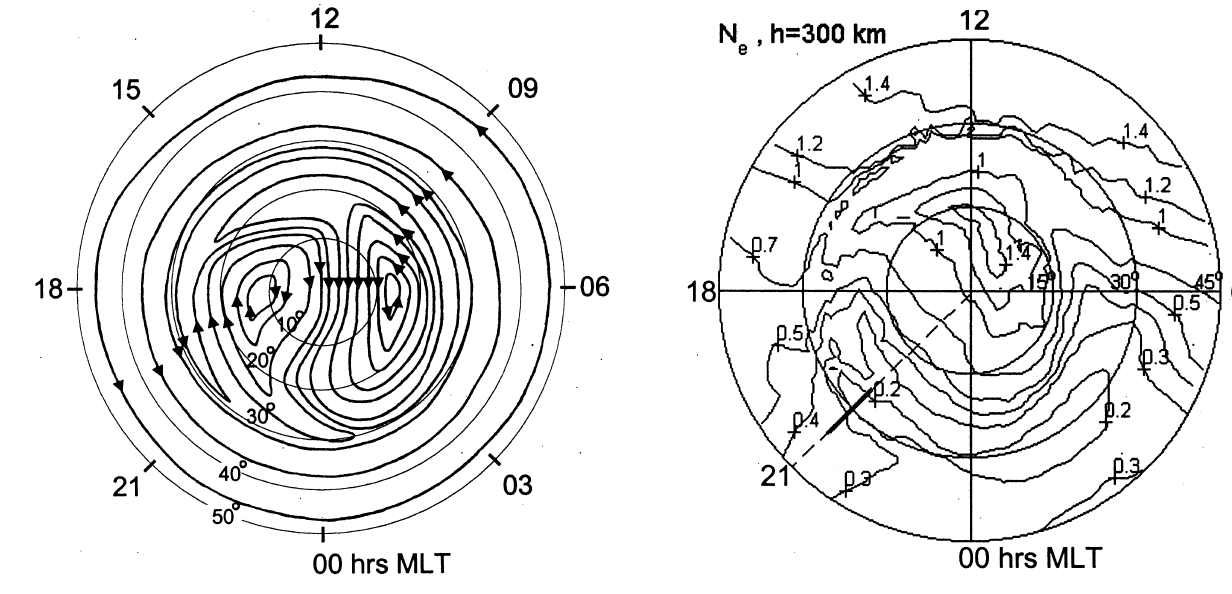
Fig. 7. Plasma convection trajectories derived from the combination of pattern B of the empirical convection model at polar latitudes by Heppner (1977) and the empirical model of ionospheric electric fields at middle latitudes by Richmond (1976) and Richmond et al. (1980). The trajectories are depicted in the fixed Sun-Earth refer- ence frame. Values of the magnetic local time (MLT) and magnetic colatitude are indicated on the plot. The arrows indicate the direc- tion of the convection flow.